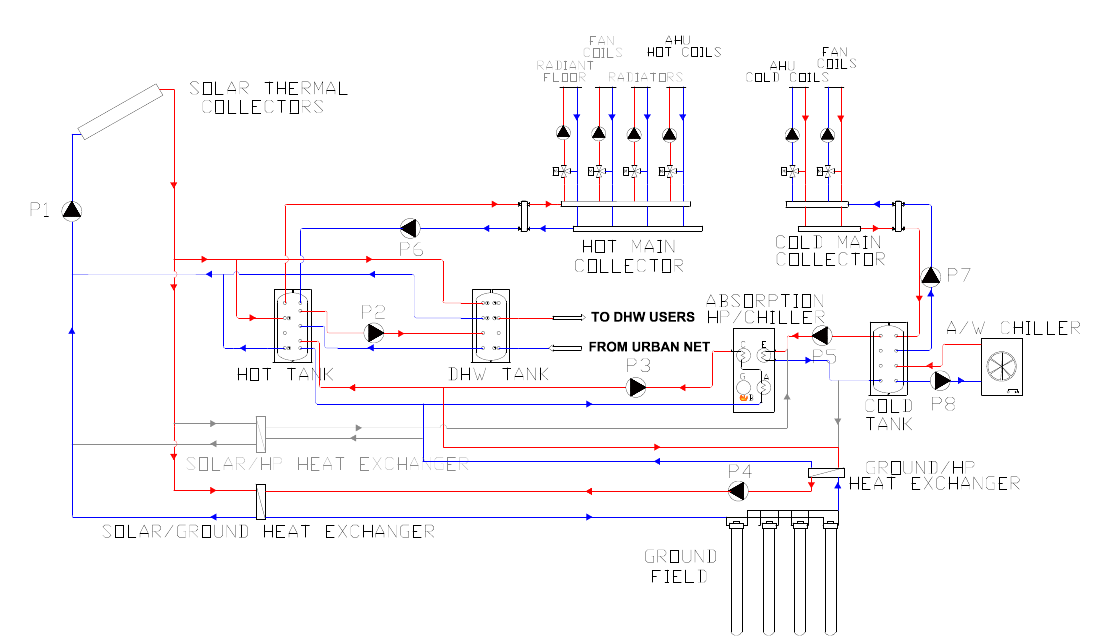
Figure 8. Simplified functional diagram of the heating, ventilation, and air conditioning (HVAC) plant. The mass flows of the main circuits (ground, solar, tanks, hot and cold collectors) are shown (the part of the plant operating during heating season only is in grey).